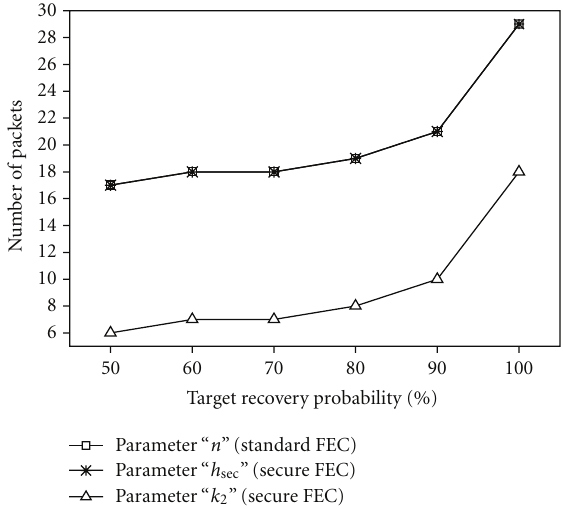
Figure 3: Coding rate for both the standard FEC and secure FEC is 2/3 with k 1 = 12.